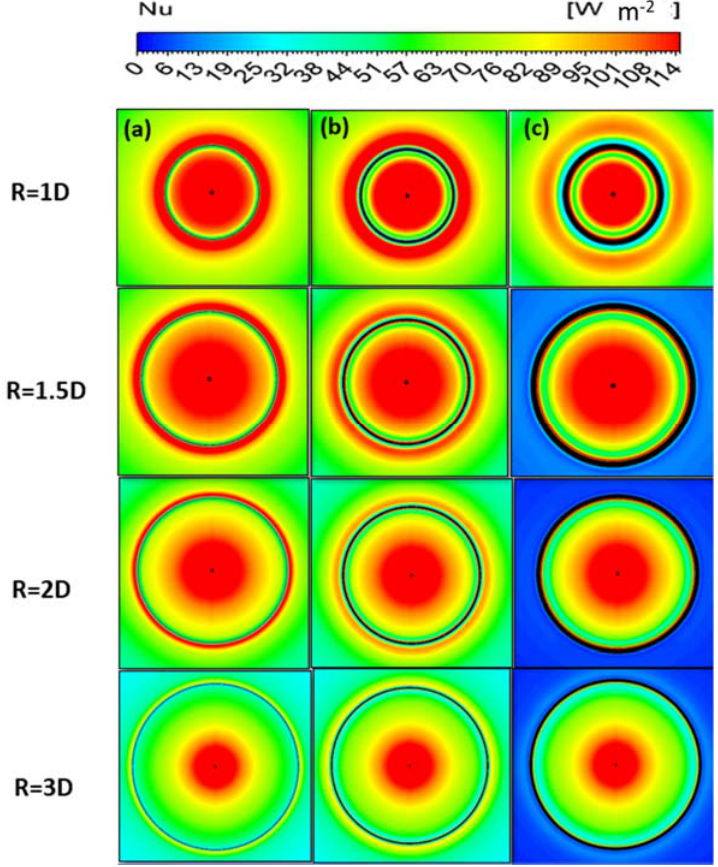
Figure 14. Local N (cid:2931) contours for three selected rib heights, ( a ) 0.25 mm, ( b ) 0.75 mm, and ( c ) 1.5 mm. Figure 14. Local N u contours for three selected rib heights, ( a ) 0.25 mm; ( b ) 0.75 mm; and ( c ) 1.5